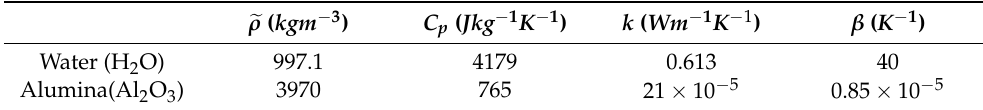
Table 3. Thermophysical features of nanoparticles and water.